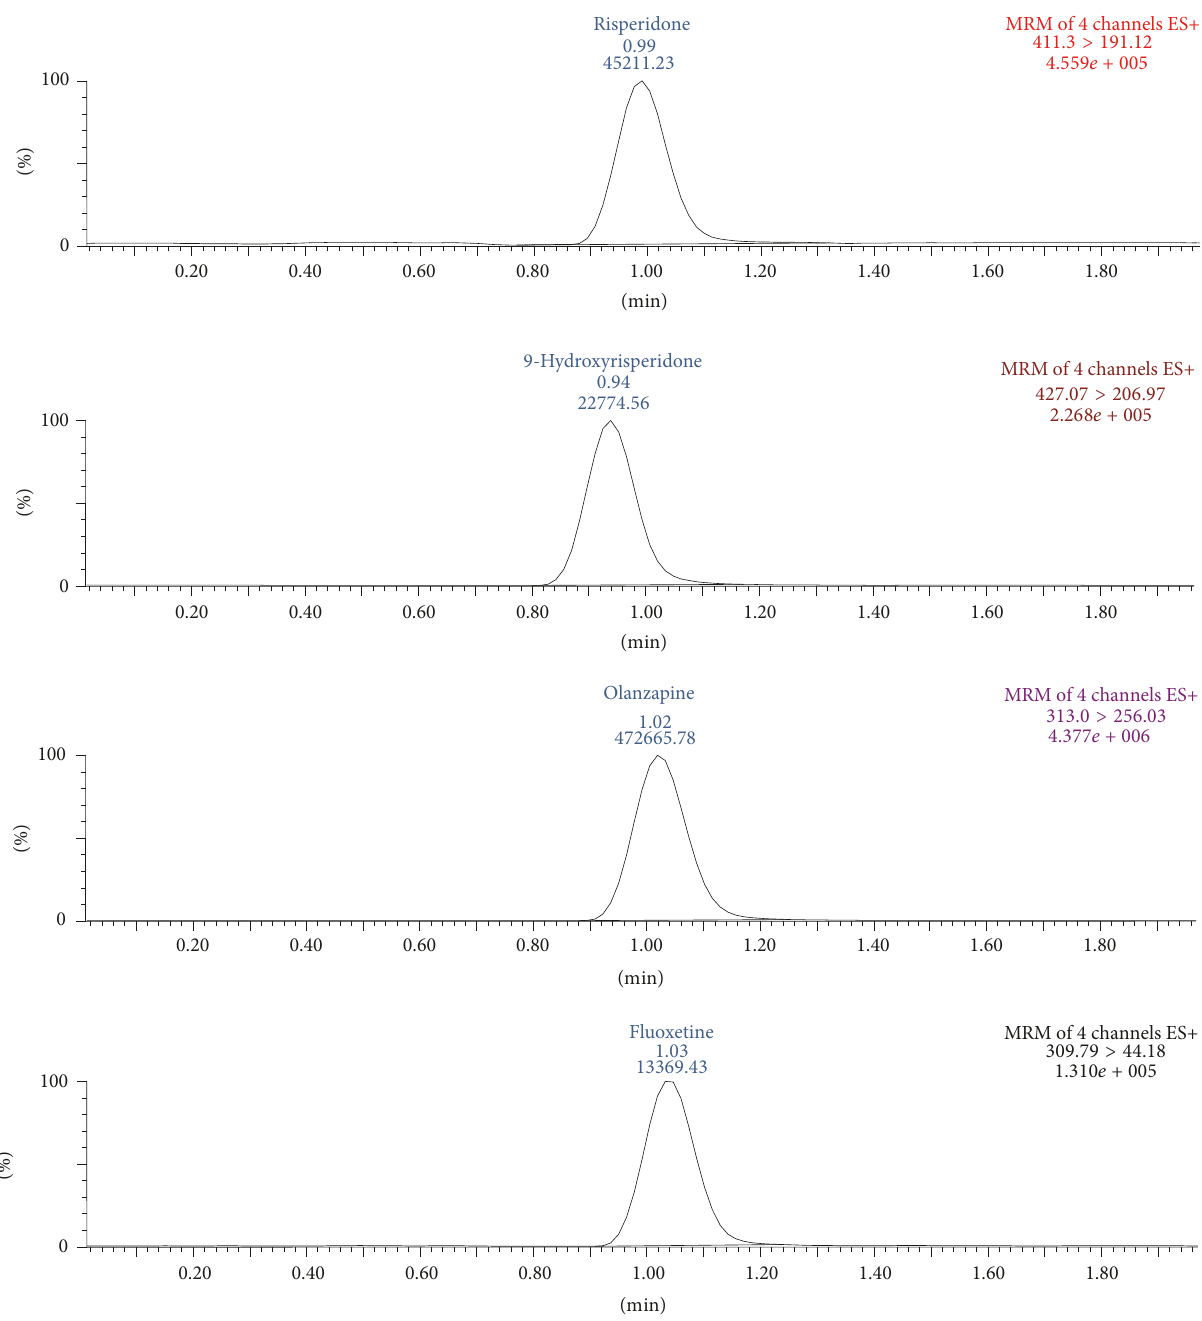
samples was calculated from the calibration curve ( 𝑦 = 𝑏𝑥+𝑎 ) and the regression coefficient was calculated. The LLOQ is the lowest concentration of the analyte on the calibration curve which is 1.0 ng/mL for FLX and 0.2 ng/mL for RIS and 9-OH-